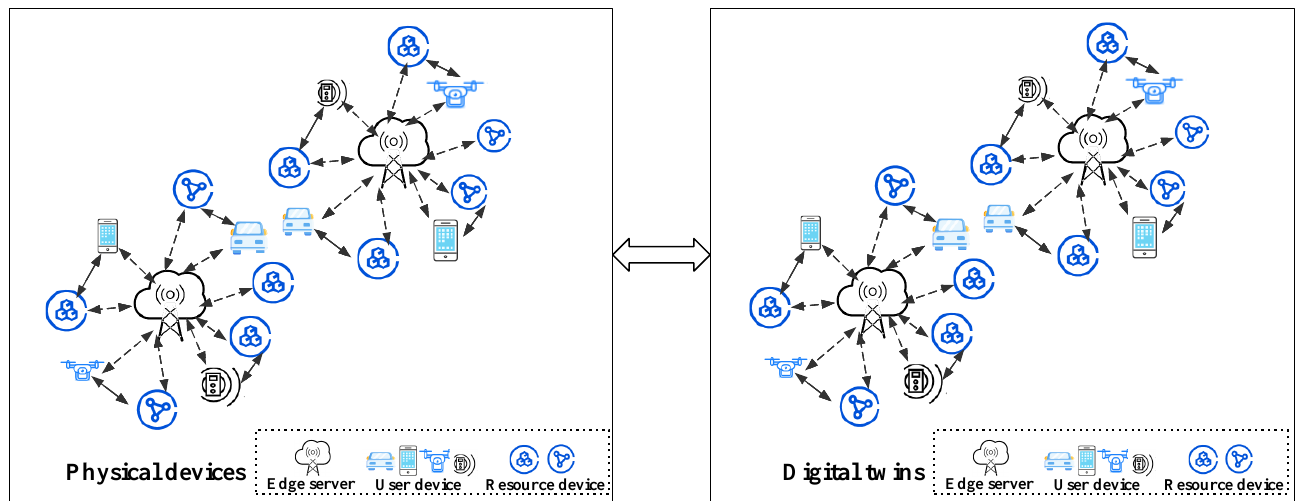
Figure 1. DT-assisted edge-computing resource-allocation